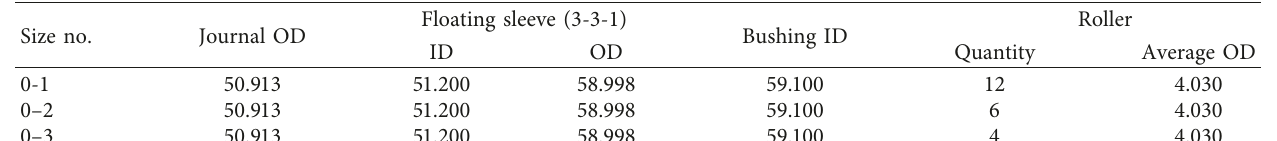
Table 2: Structure parameters of floating-sleeve bearing samples (mm).